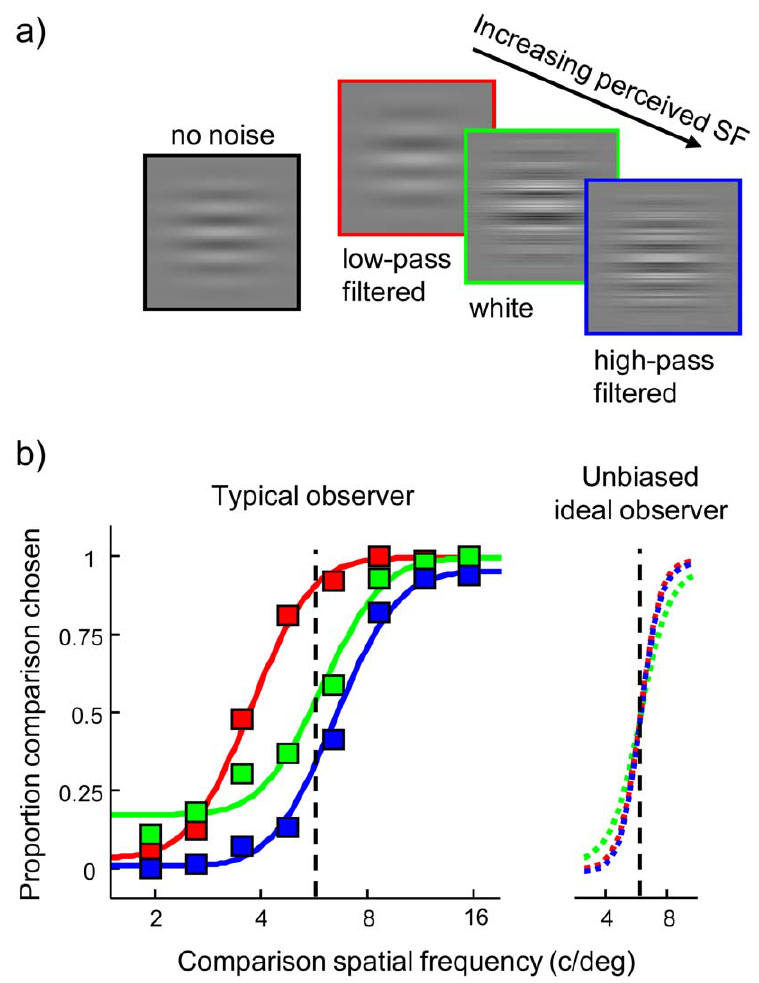
Figure 1. Spatial frequency perception is biased in filtered noise. (a) The perceived spatial frequency of a grating embedded in low-pass noise (red) and high-pass noise (blue) is respectively lower and higher than the perceived spatial frequency of the same grating embedded in white noise (green). (b) Left panel: results of a typical observer (BM). The spatial frequency of a comparison grating embedded in white noise was varied to match a standard grating of 5.5 c/deg in low-pass filtered, high-pass filtered and white noise. In low-pass and high-pass filtered noise, a respectively lower and higher comparison frequency is required to match the standard grating, indicating that perceived standard grating frequency is biased in the direction of the noise. Full lines represent the best-fitting Weibull psychometric functions. Right panel: an ideal observer model adopting optimal narrow read-out functions to sample the likelihood function predicts unbiased discrimination performance.